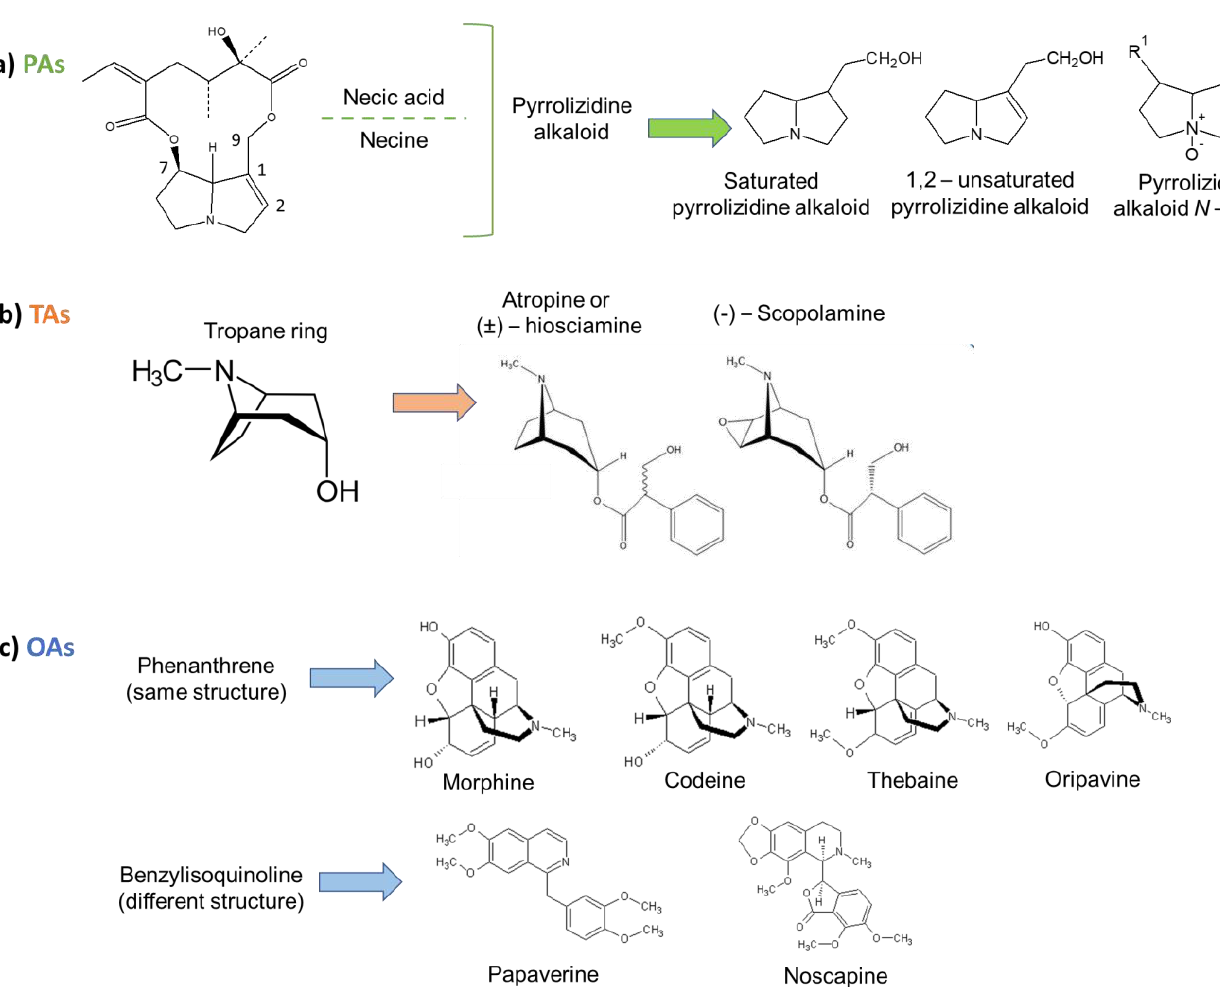
Figure 2. ( a ) Common chemical structure of pyrrolizidine alkaloids and different forms for pyrrolizidine alkaloids (R1 and R2 correspond to different necic acids); ( b ) General common chemical structure of tropane alkaloids (TAs), and chemical structure of the main TAs: atropine and scopolamine; ( c ) Chemical structures of the two families of opium alkaloids (phenanthrenes and benzylisoquinolines).